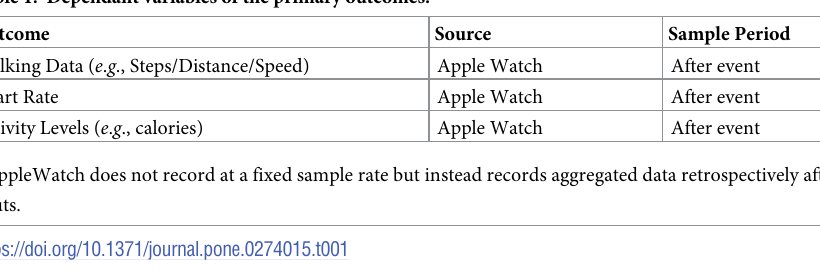
Table 1. Dependant variables of the primary outcomes. Outcome Source Sample Period